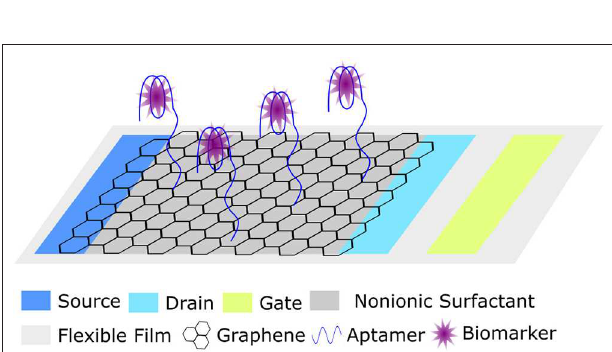
FIGURE 9 | Schematic representation of a wearable ultra-flexible graphene field effect transistor (GFET) for biomarker detection (Wang et al., 2019).